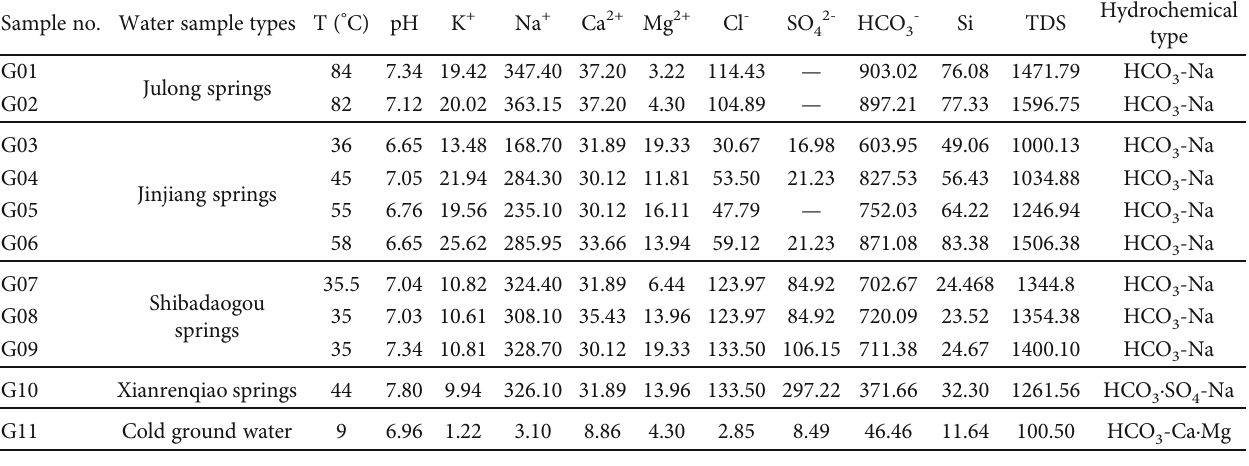
Table 1: Hydrogeochemical data of selected thermal water samples from the Changbai Mountain volcanic region (mg/L).